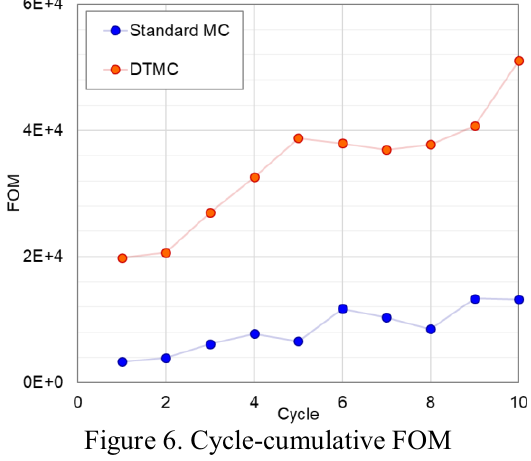
Figure 6. Cycle-cumulative